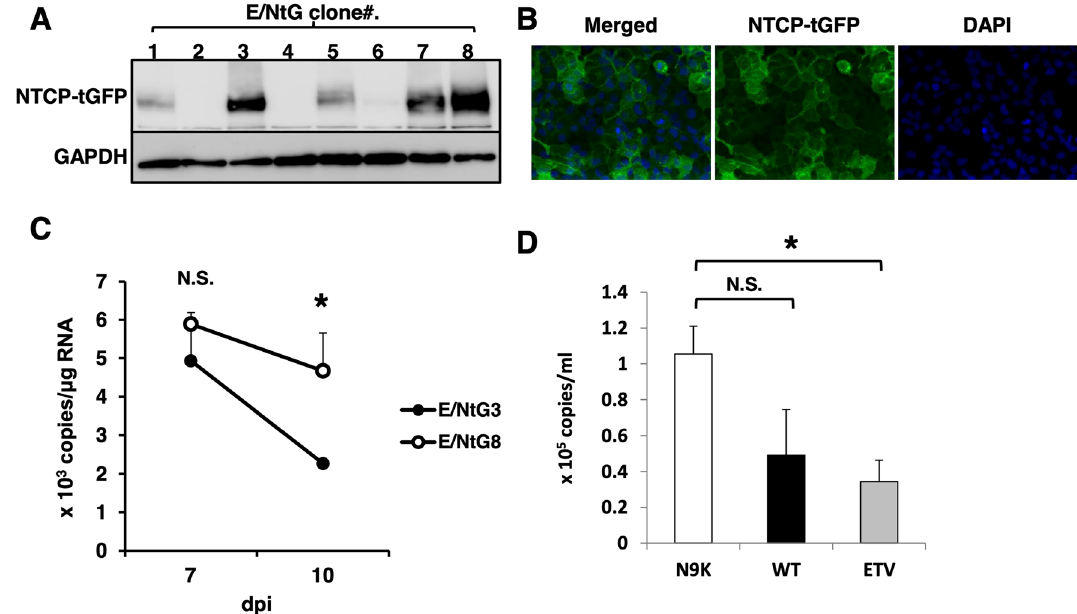
Figure 1. ( A ) Production of NTCP-tGFP was observed by immunoblot analysis using anti-tGFP antibody. GAPDH in the samples was detected by anti-GAPDH antibody to show as the loading control. Full-length blot images were presented in Supplemental Figs. Fig. S8 and Fig. S9. ( B ) Fluorescence imaging of E/NtG8 cells cultured on a collagen-coated chamber slide. NTCP-tGFP and DAPI-stained nuclei were shown in green and in blue, respectively. ( C ) E/NtG3 (closed circle) and E/NtG8 cells (open circle) were infected with HBVcc. The copy number of HBV pgRNA in the cells harvested at the indicated time points was evaluated by qRT-PCR. The dpi indicates “days post infection”. ( D ) E/NtG8 cells were infected with HBVcc in the presence of myr-47WT (WT) (black bar) or myr-47N9K (N9K) (white bar). After 2 weeks of culture in the presence (gray bar) or absence